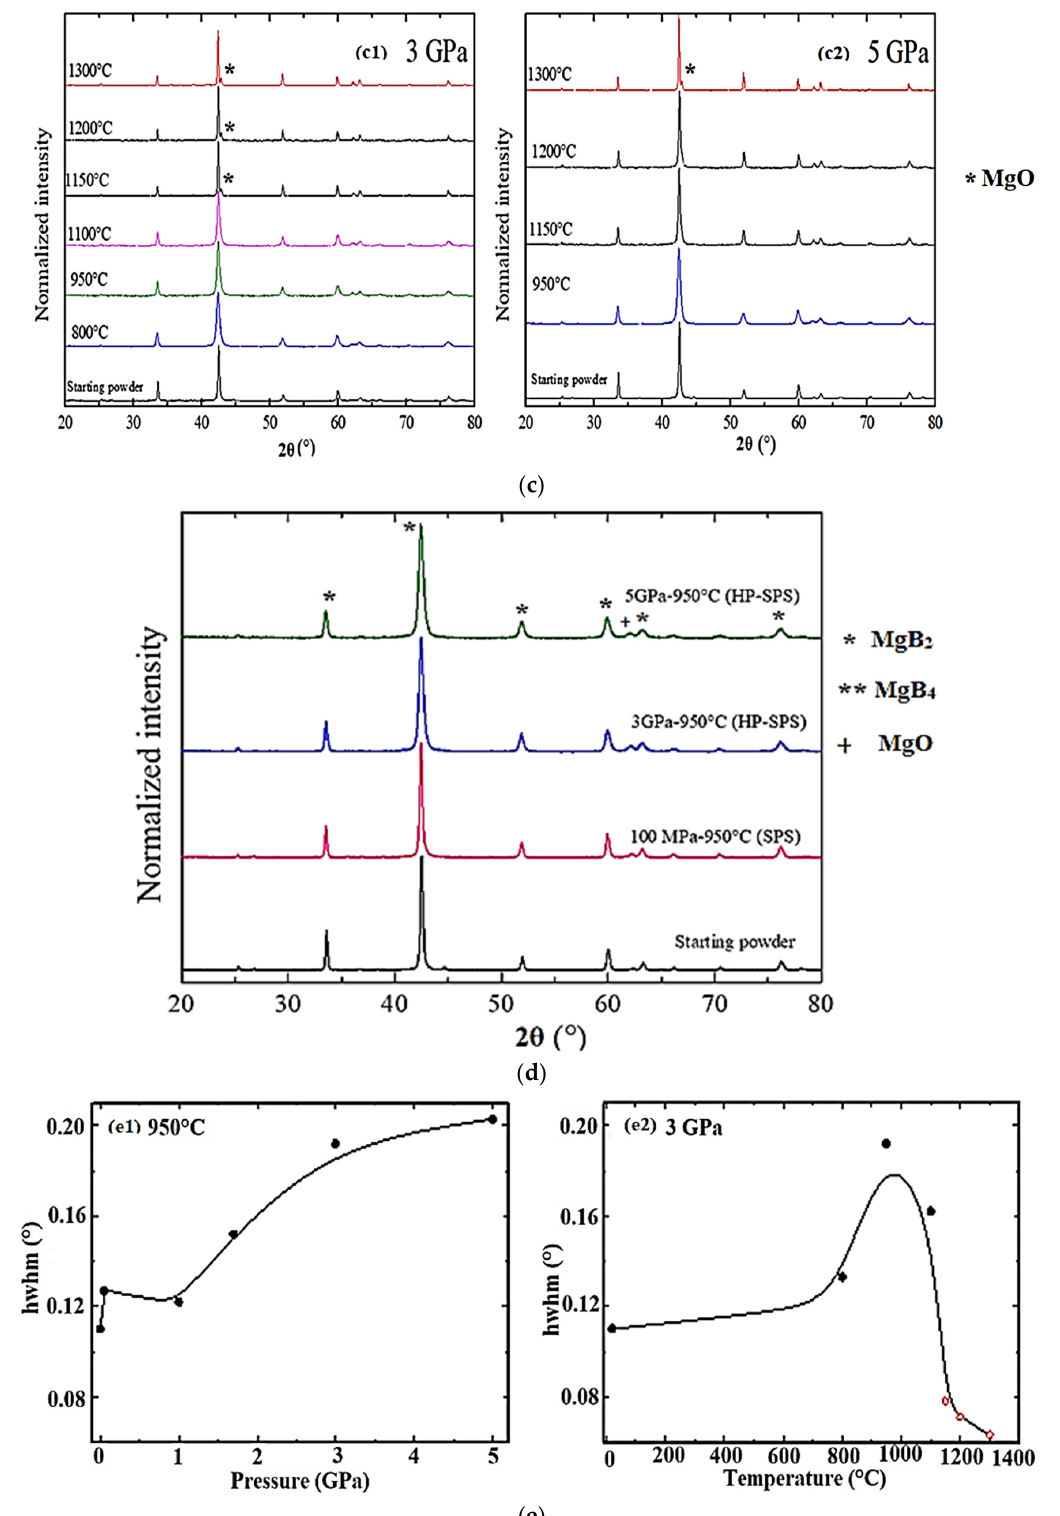
Figure 1. ( a ) Phase stability of MgB 2 with temperature at ambient pressure by in situ XRD. ( b ) Phase stability of MgB 2 with temperature at 100 MPa and decomposition of MgB 2 at 1250 °C. ( c ) Phase stability of MgB 2 with temperature at (c1) 3 GPa and (c2) 5 GPa. ( d ) Phase stability of MgB 2 with pressure at 950 °C ( e ) Evolution of peak (101) width by XRD on MgB 2 with (e1) Pressure at 950 °C and (e2) Temperature at 3 GPa.